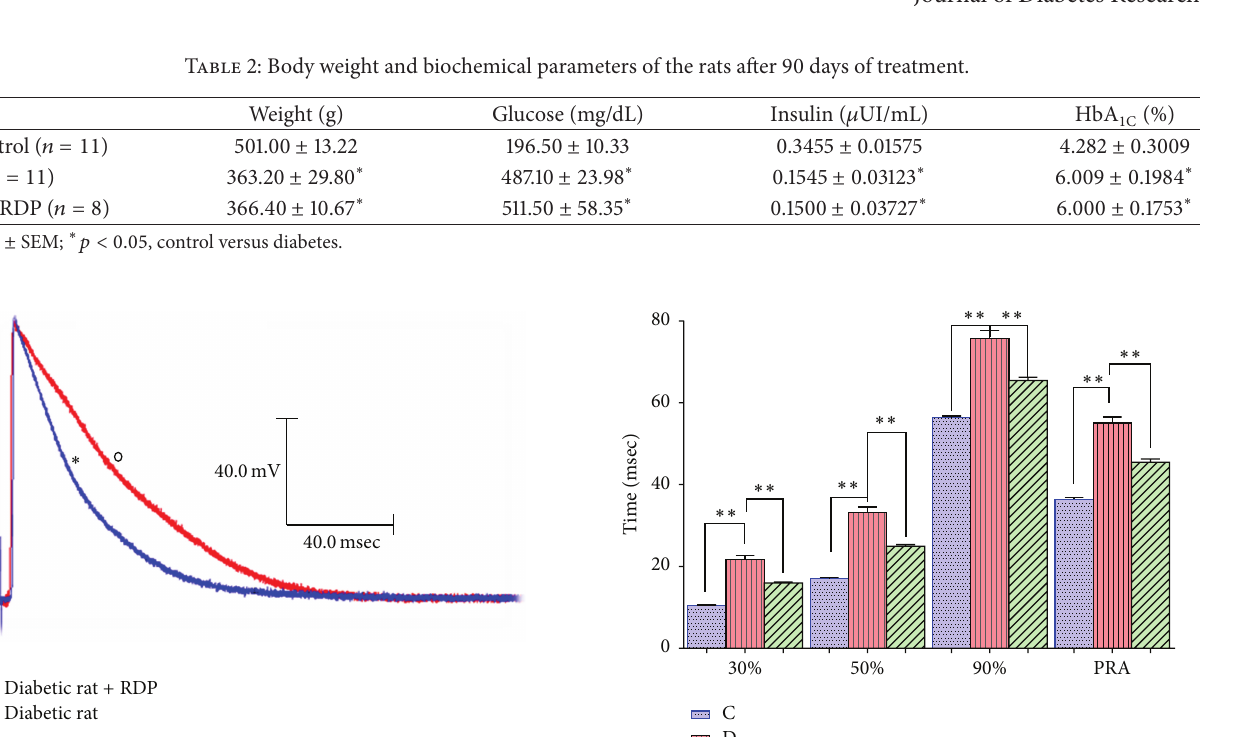
Figure2:Actionoftheapplepeelontheactionpotentialsofdiabetic rats. Typical transmembrane potentials obtained in the papillary muscles of the heart of diabetic rats and diabetic rats with apple peel at a basic cycle of 500 milliseconds.